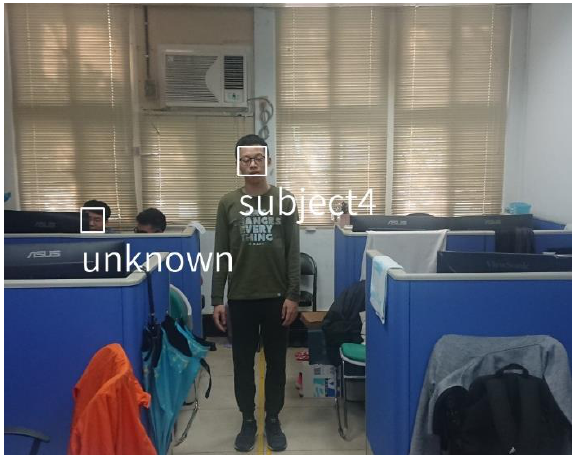
Figure 8. Adaptive tolerance for Euclidean distance in the facial recognition task.